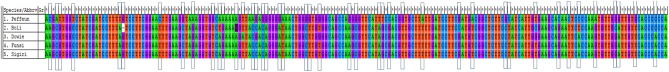
Aligned nucleotide sequences of genomic regions of Kersting's groundnut landraces generated by CLM0044 primer.